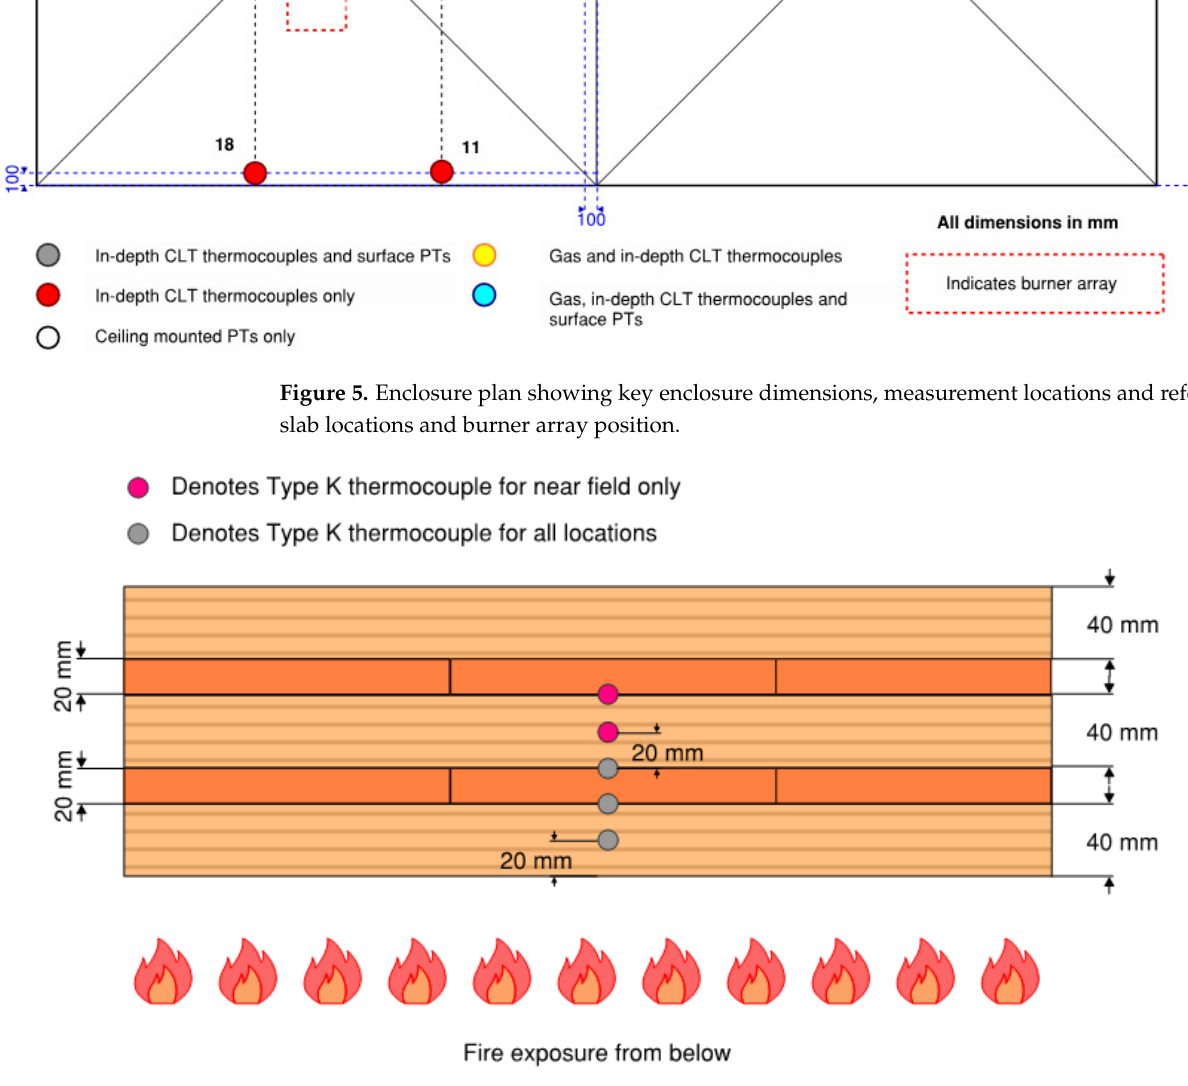
Figure 6. In-depth thermocouple positions in CLT for Experiments 2 and 3.